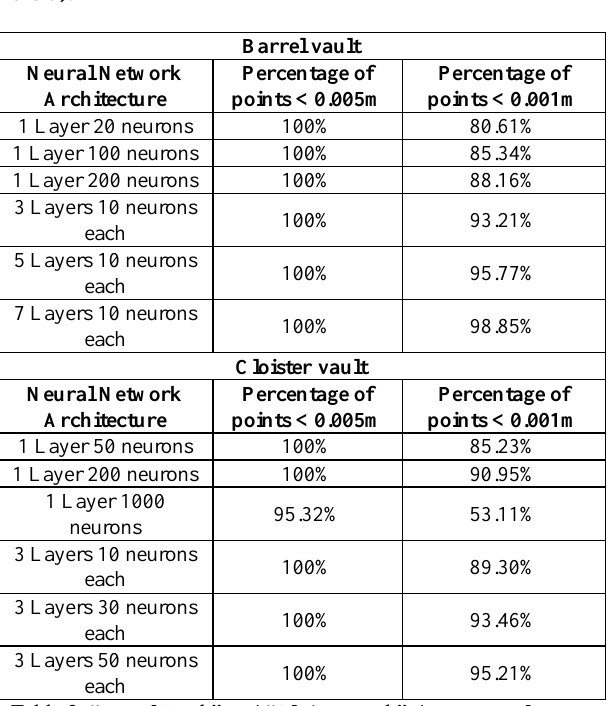
Figure 10. Results for a synthetic cloister vault: (a) original point cloud; (b) result with 3 layers (10 neurons in each); (c) results with 3 layers (30 neurons in each); and (c) results with 3 layers (50 neurons in each) (color scale is the same for images b-c-d).